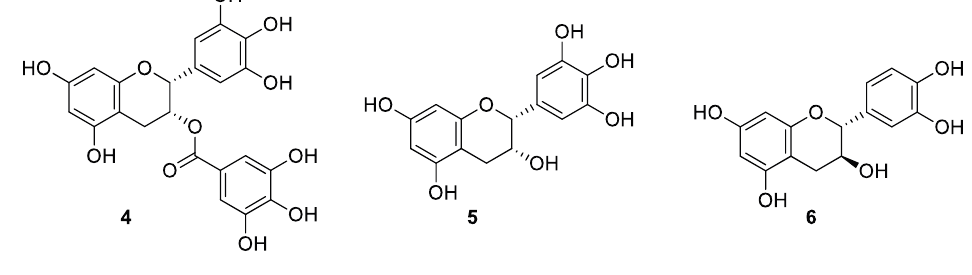
Figure 2. Structure of principal